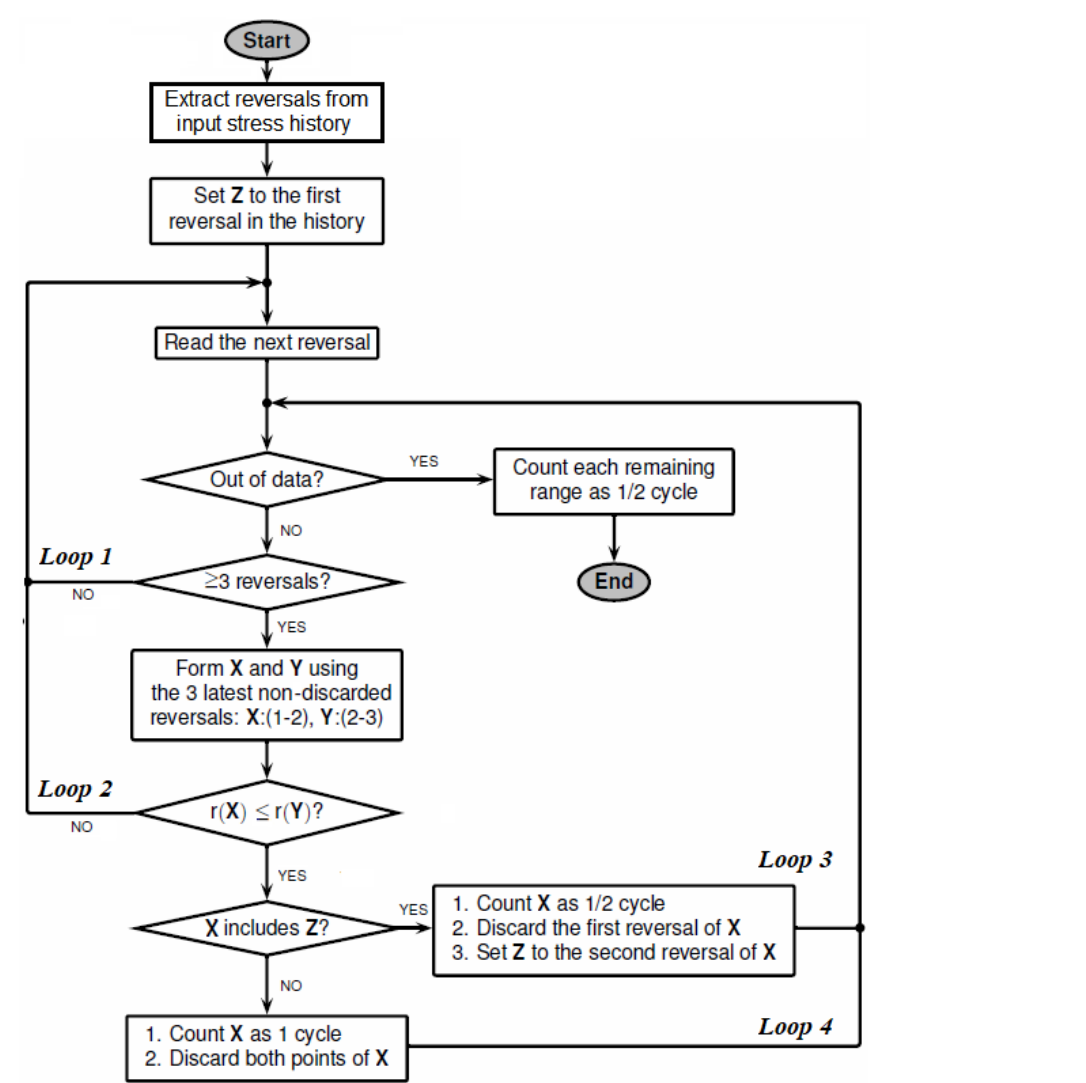
Figure 1. Flowchart of the MATLAB implementation rainflow() of the three-point algorithm (simplified from The MathWorks Inc., 2018). Stress extrema are called “reversals”. The range r ( X ) = | X (2) − X (1) | of a stress value pair X is the absolute value of the difference between both